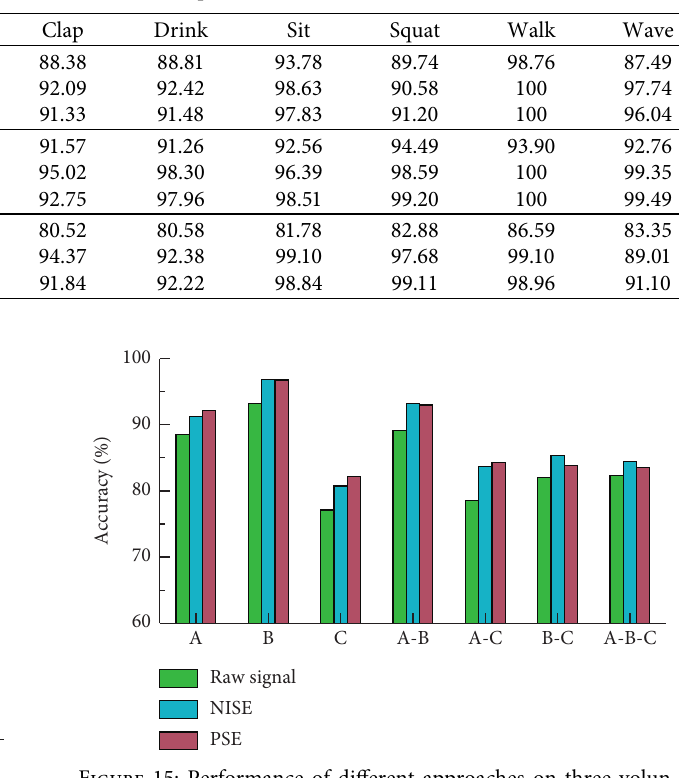
Table 2: Accuracy of different activities in each experimental scenario.